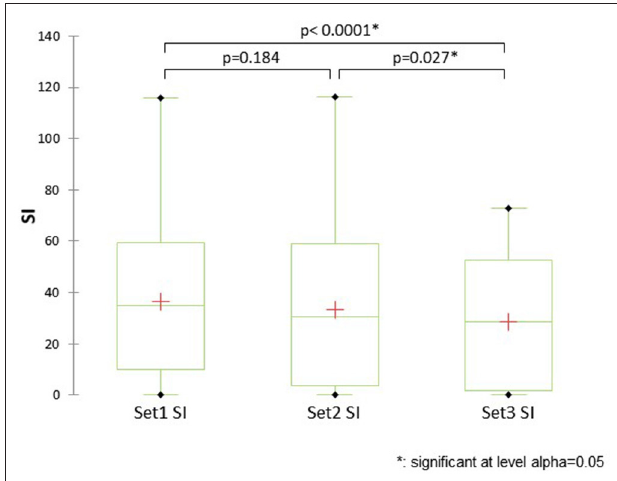
FIGURE 6 | Comparison between canine stress index by handling